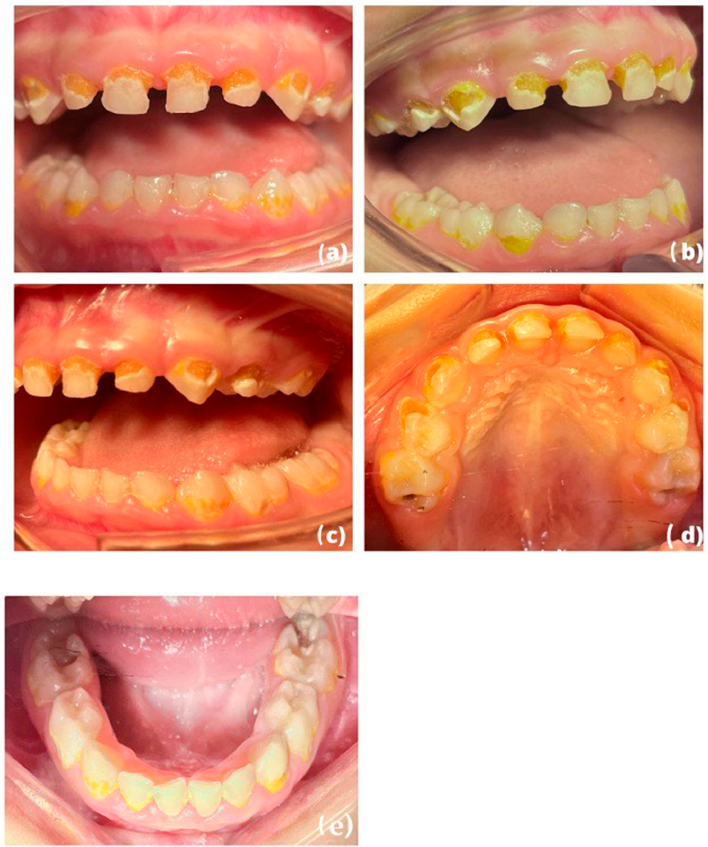
Figure 1. ( a – e ): Endobuccal photograph taken during the intervention under general anesthesia (frontal, right, left, maxillary, and mandibular occlusal view) of our 4-year-old patient illustrating the severity of the clinical situation: early childhood caries affecting all of his teeth.